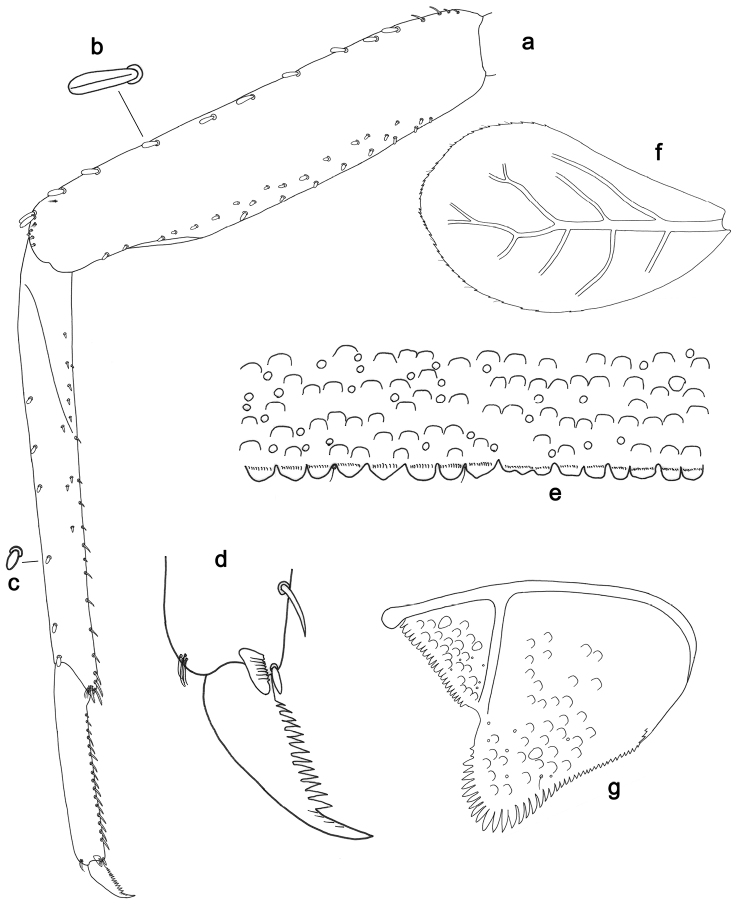
Labiobaetispapuaensis sp. n., larva morphology: aForelegb Femur dorsal seta c Tibia dorsal seta d Fore claw eTergum IV f Gill IV gParaproct.